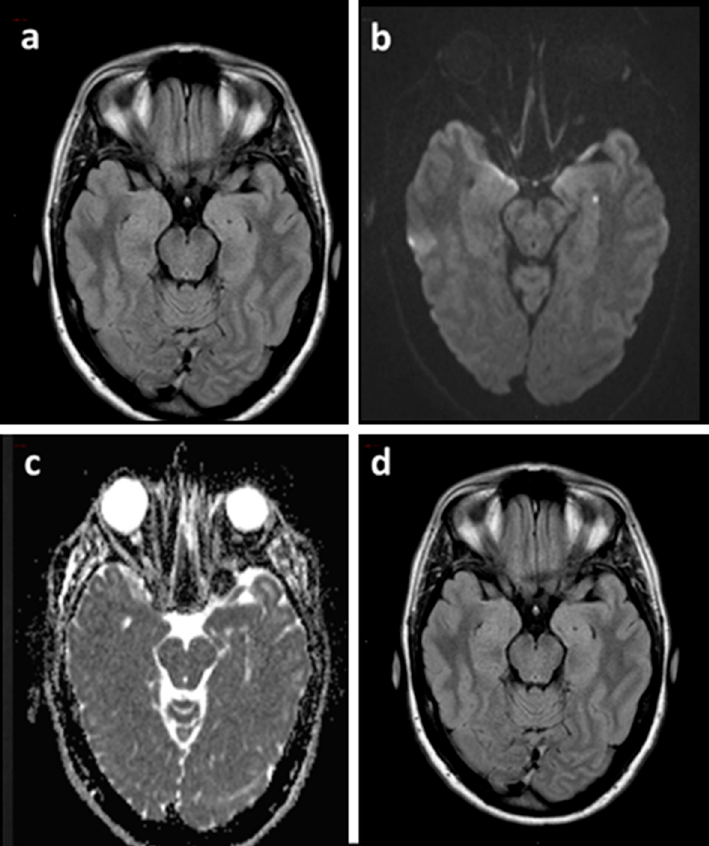
Figure 2. Brain MRI of a TGA patient acquired 48 h after the episode ( a – c ) and at three months ( d ). Axial FLAIR sequence ( a ) showing both hippocampi without signal abnormalities corresponding to the punctate DWI hyperintensity ( b ) with ADC hypointensity ( c ) in the left hippocampus. Axial FLAIR sequence at three months ( d ) confirmed the absence of signal abnormalities. ADC: Apparent Diffusion Coefficient